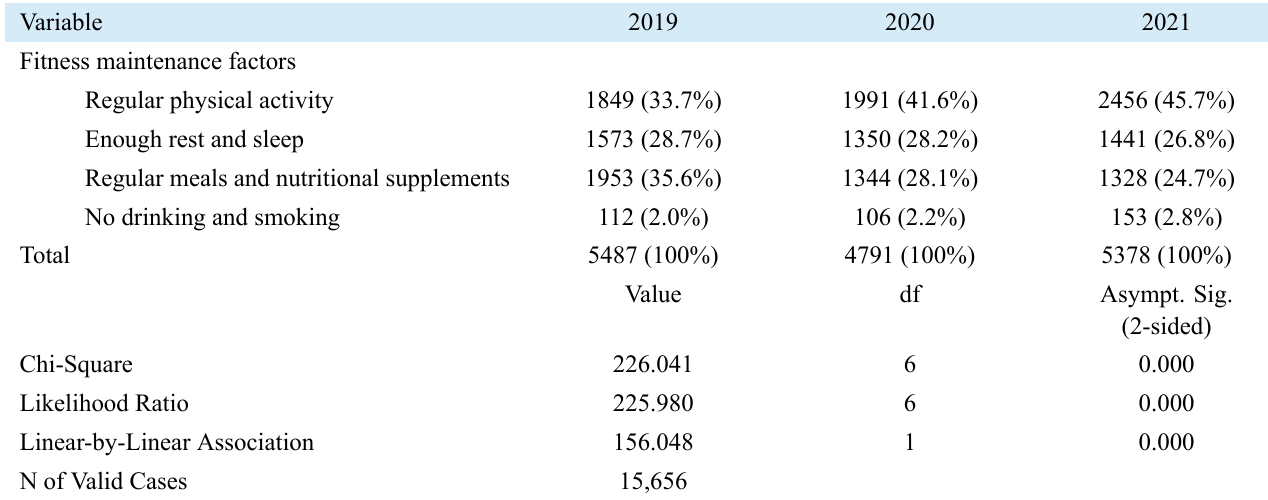
TABLE 6. Changes in fitness maintenance factors by year